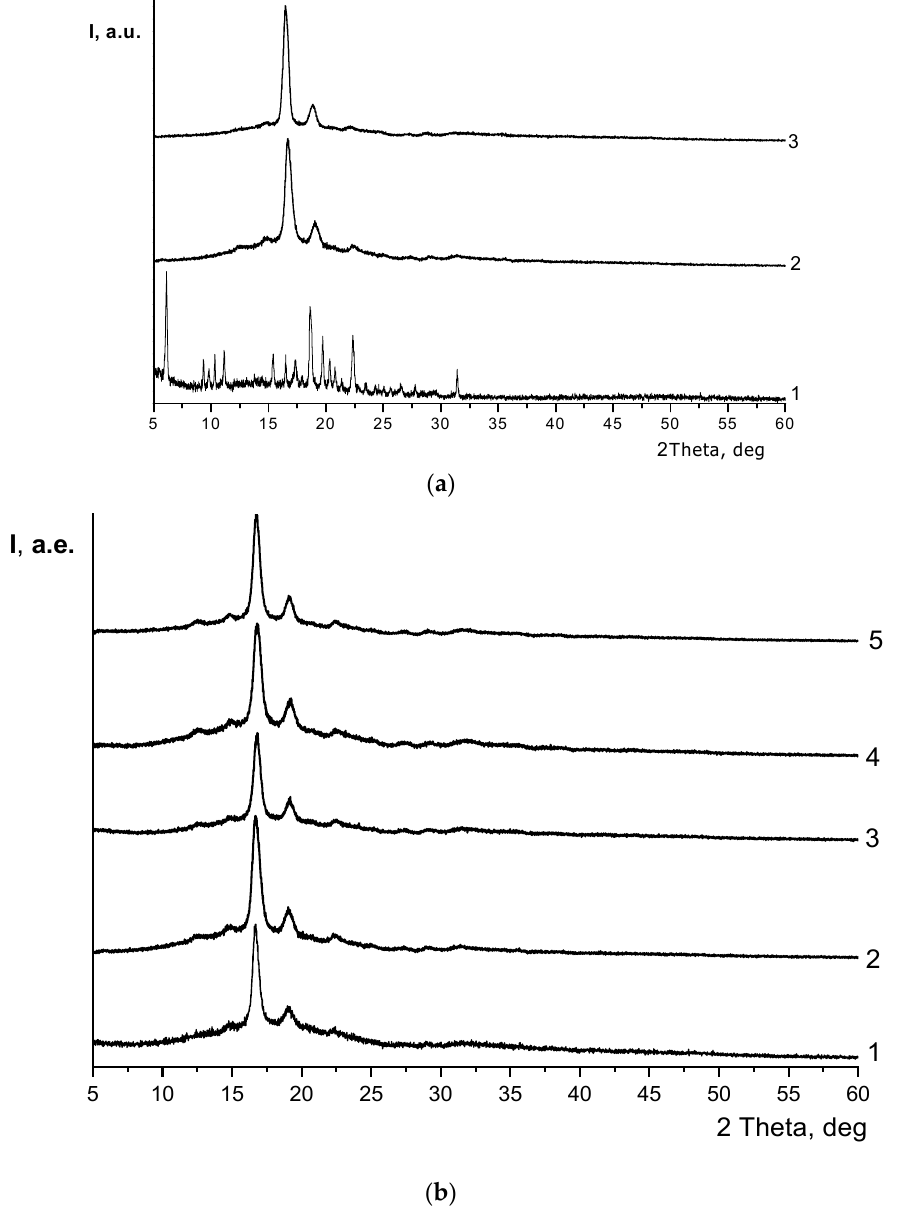
Figure 3. ( a ) Diffractograms of TPP4OC 6 (1), PLA granules (2), and PLA film (3). ( b ) Diffractograms PLA (1) and composites PLA–TPP4OC 6 with TPP4OC 6 content, wt.%: 0.2 (2), 0.3 (3), 0.4 (4), and 0.5 (5).